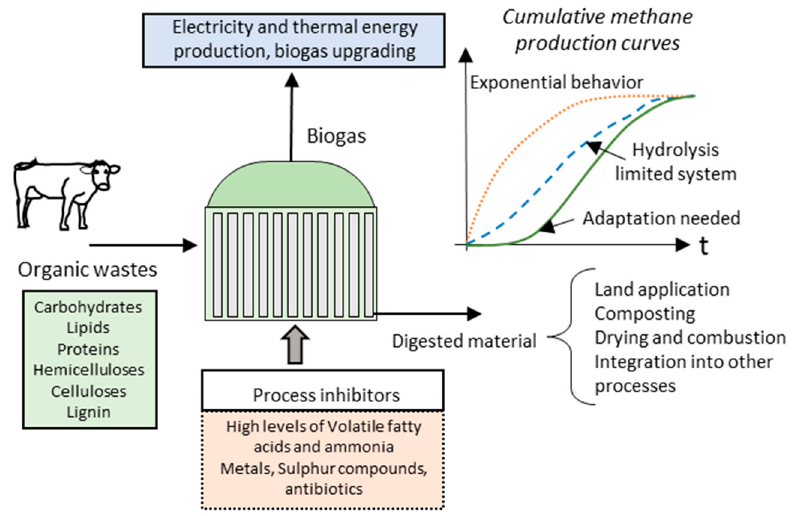
Figure 1. Schematic representation of the digestion process indicating main components of organics along with biogas and digested material derived from the process. A representation of common behavior of cumulative biogas production curves obtained under batch tests is also included.